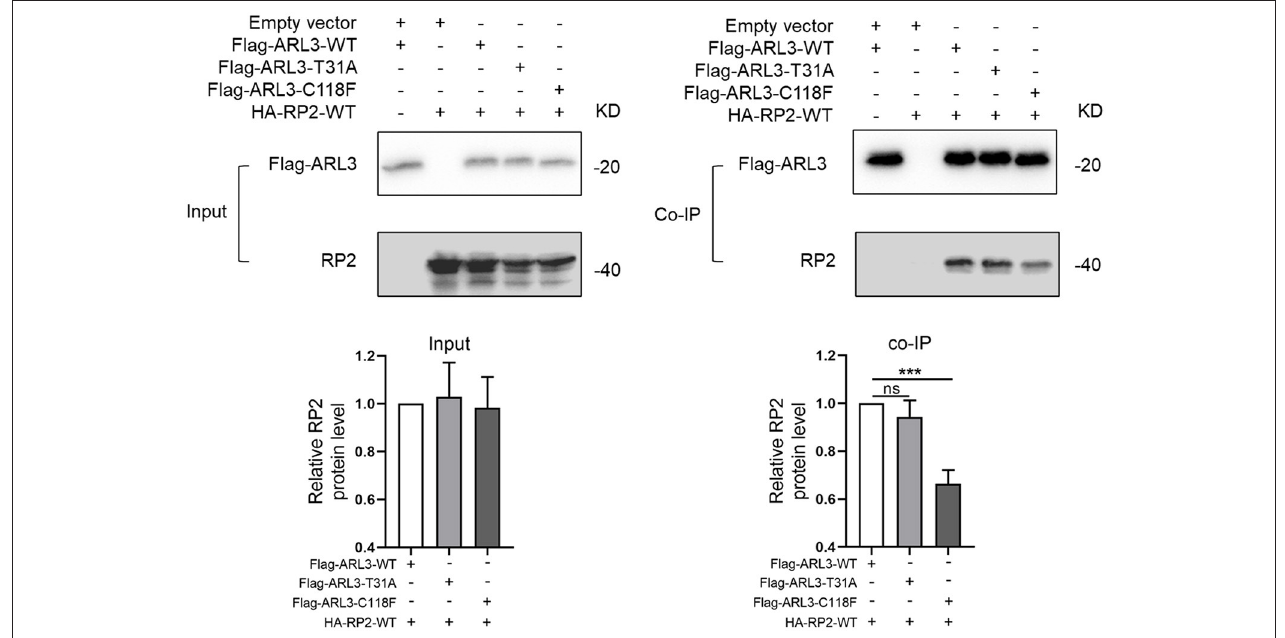
FIGURE 6 | ARL3 variants T31A and C118F disrupted the combination between ARL3 and RP2. Plasmids of HA-RP2-WT were co-transfected with wild-type or mutant Flag-ARL3 plasmids into HEK293T cells. ARL3 was immunoprecipitated with anti-Flag antibody. Western blotting was performed to detect the specific proteins indicated on the left side of each panel (Error bars indicate means ± SD; n = 3, *** p <